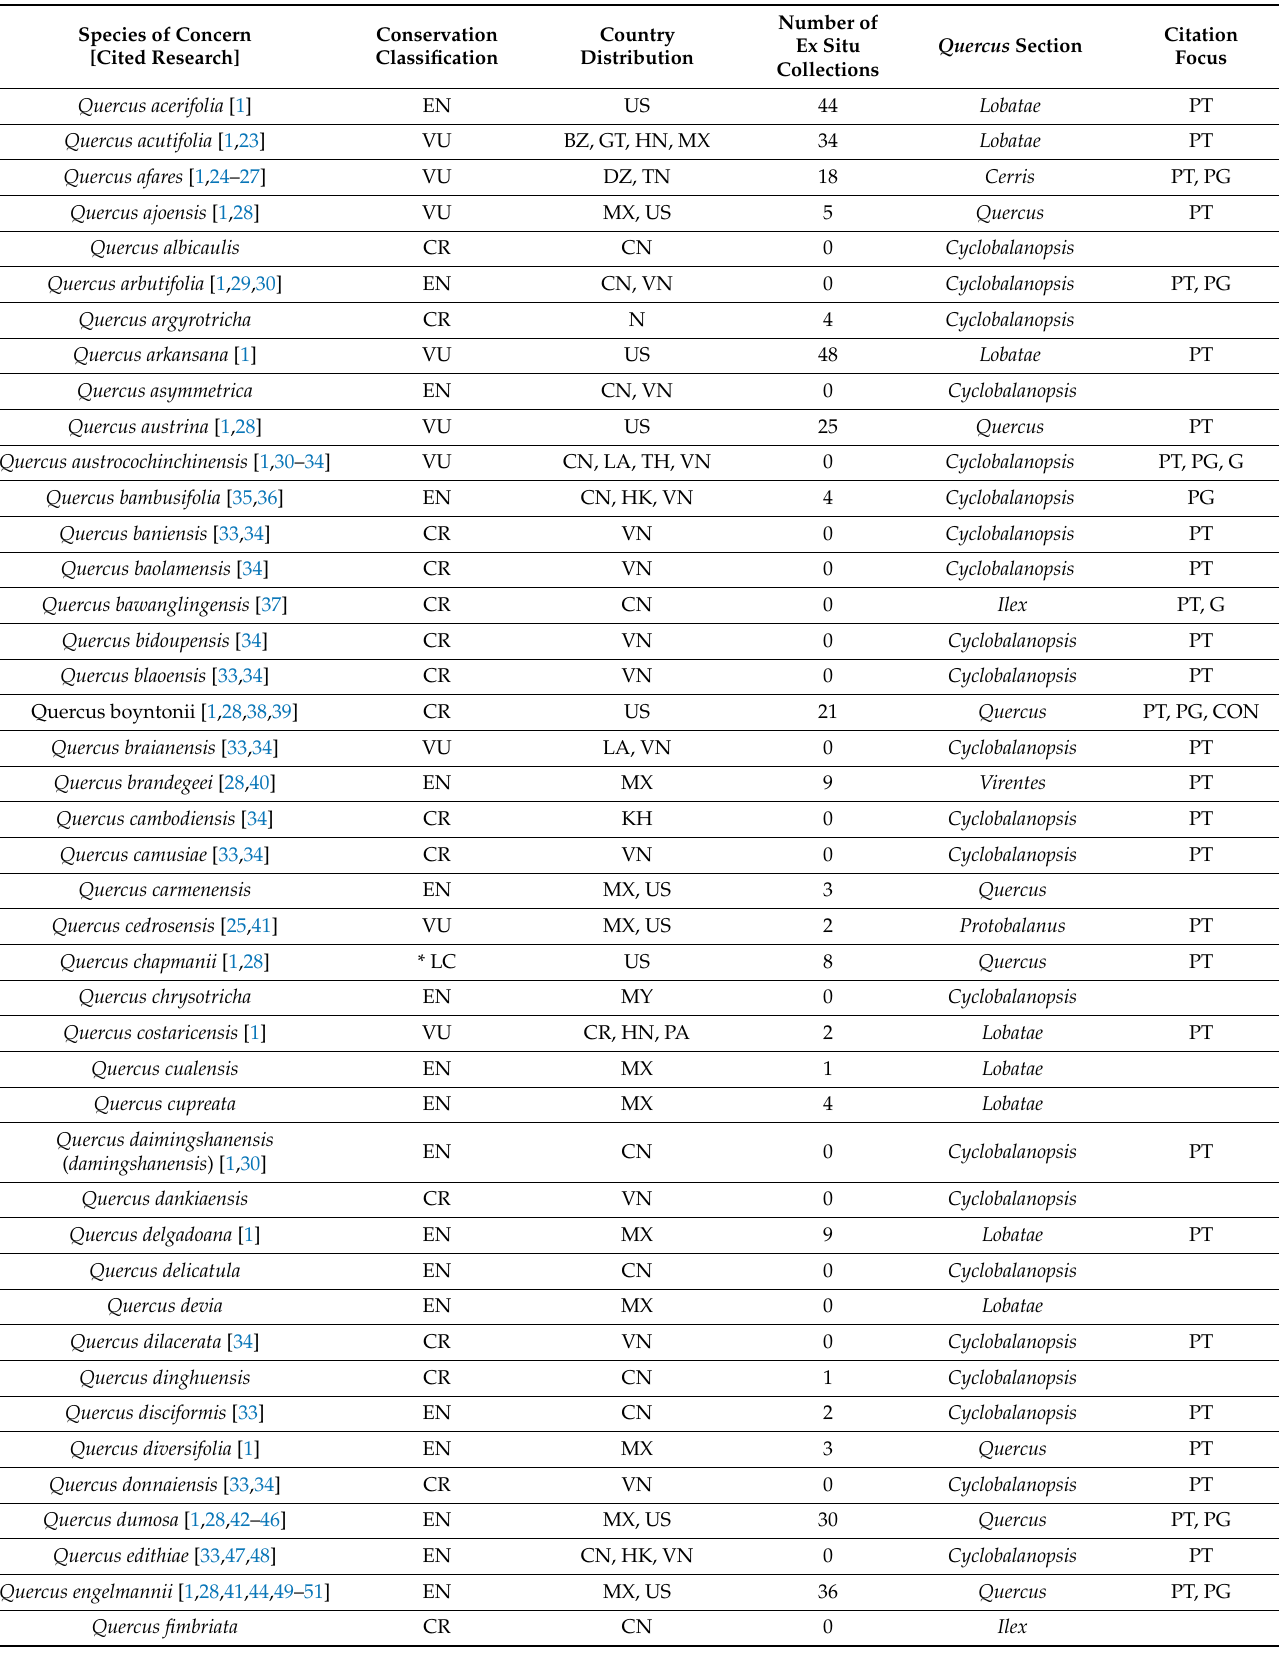
Table 1. Species of Concern and genetic research